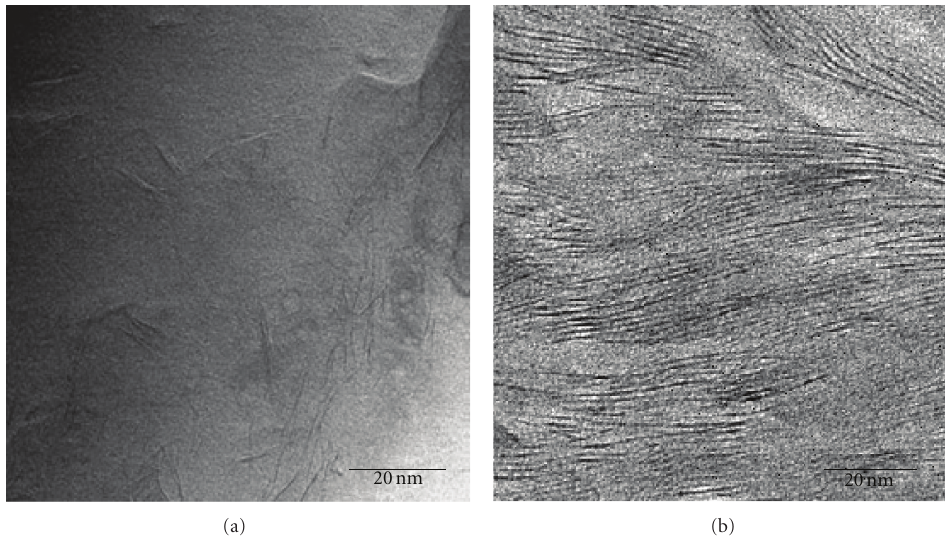
Figure 3: TEM micrographs of PAN/MMT nanocomposites (a) 5% and (b) 10%w/v.